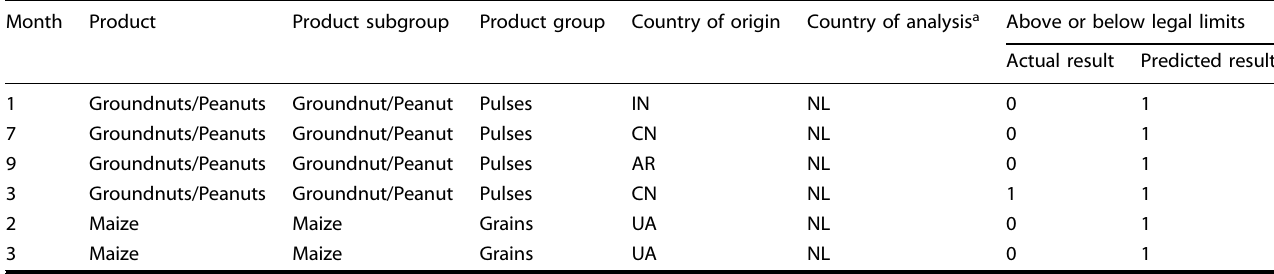
Table 2. Examples of the predicted high-risk batches using the best performing ML algorithm for 2016 – 2018.